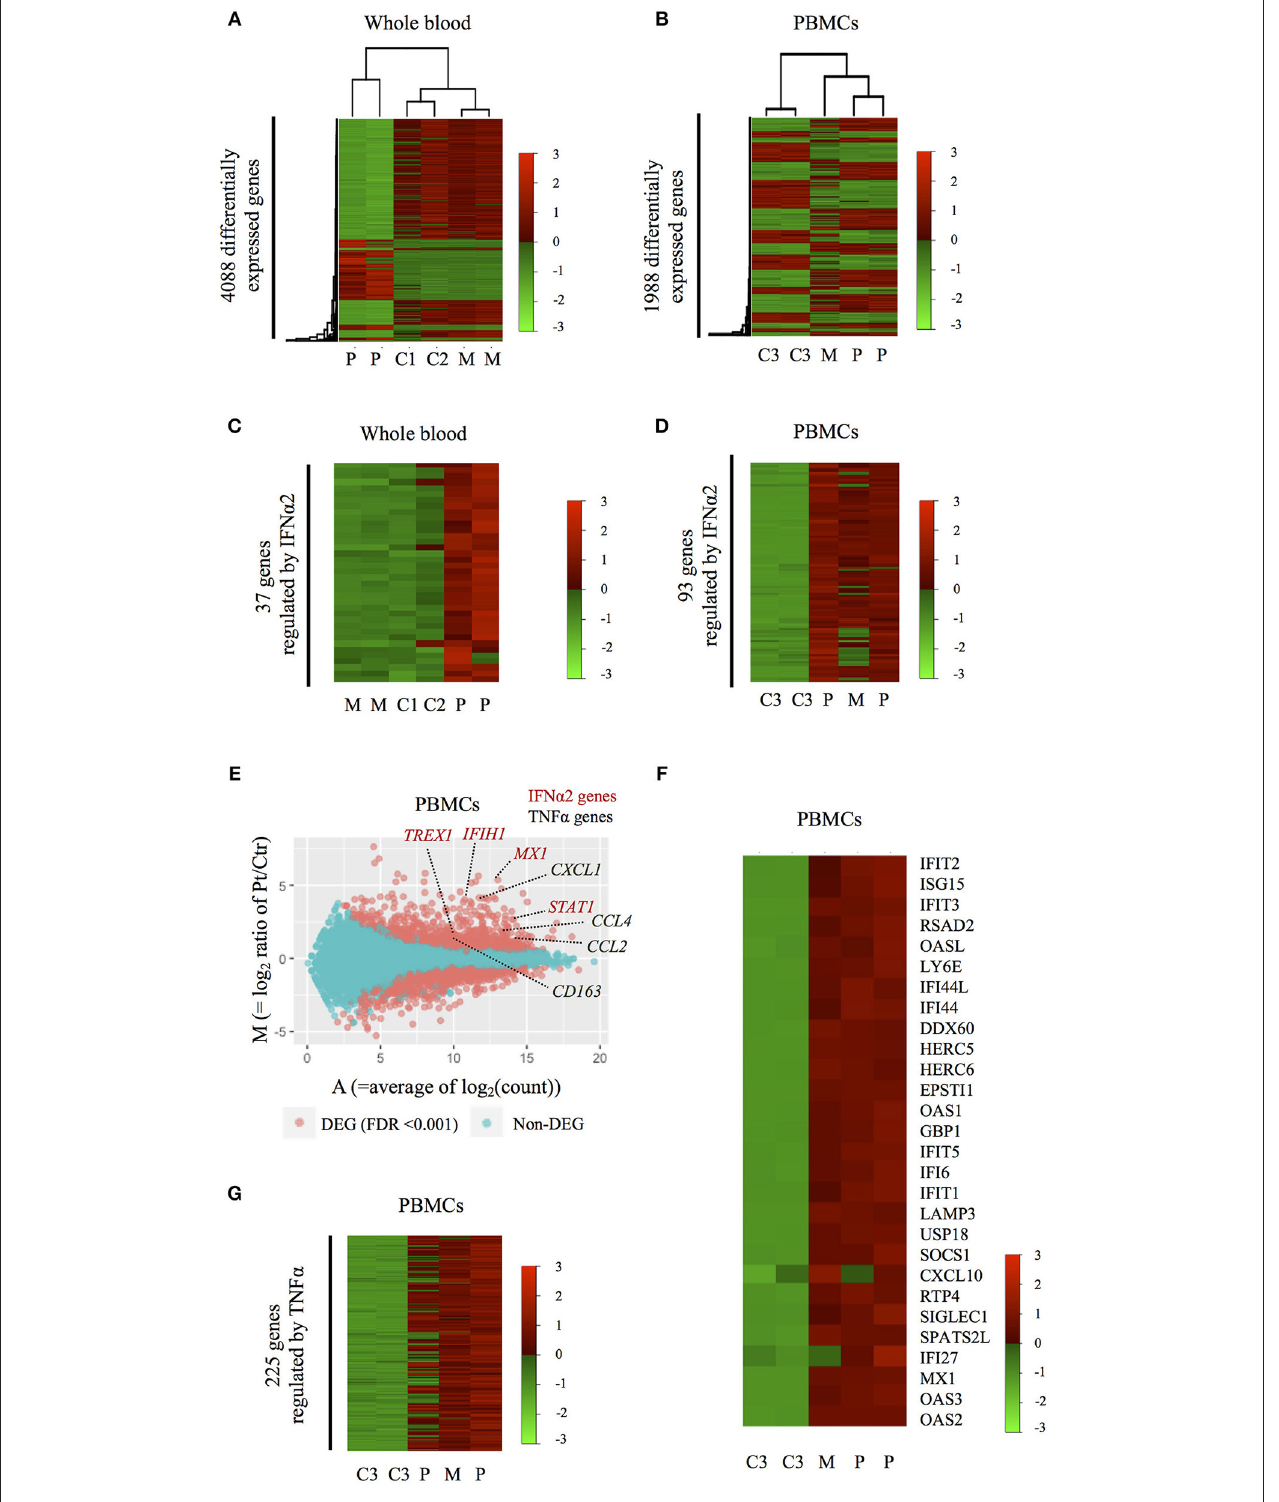
FIGURE 4 | Inflammatory signatures of the HOIP deficient patient. (A,B) Heatmaps showing genome-wide expression change in the patient’s whole blood (A) and PBMCs (B) obtained during symptom-free periods. C1-3, M, and P indicate healthy unrelated controls, the mother and the patient, respectively. (C,D) Heatmaps